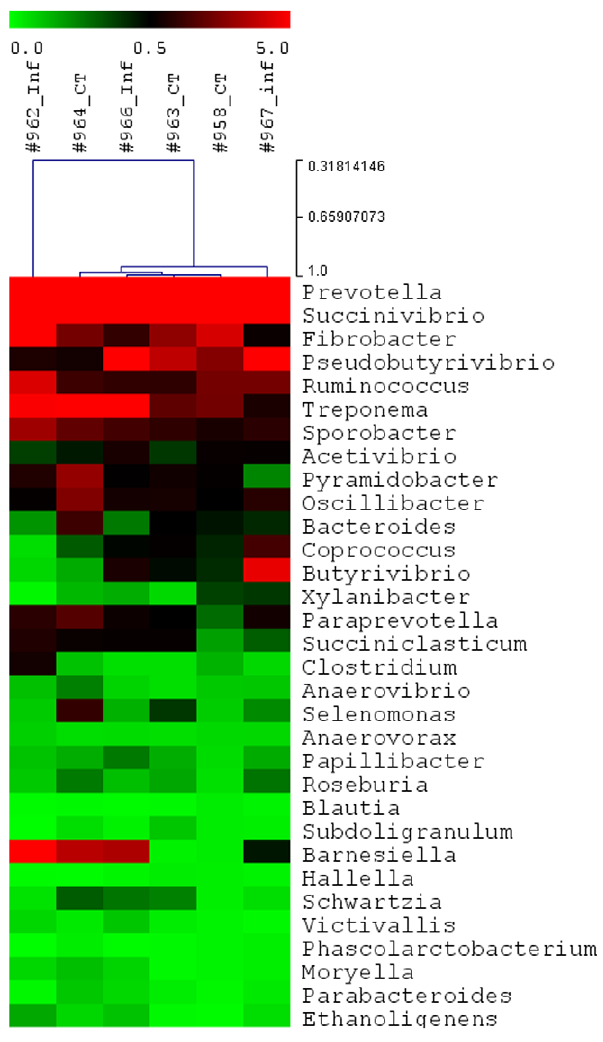
Figure 5. A heatmap of the bovine abomasal microbiota composition at a genus level. 32 genera that shared by all samples tested (core microbiome) were displayed. The scale (log 2) was the percentage composition based on the 16S rDNA sequences using RDP Classifier at an 80% confidence threshold.